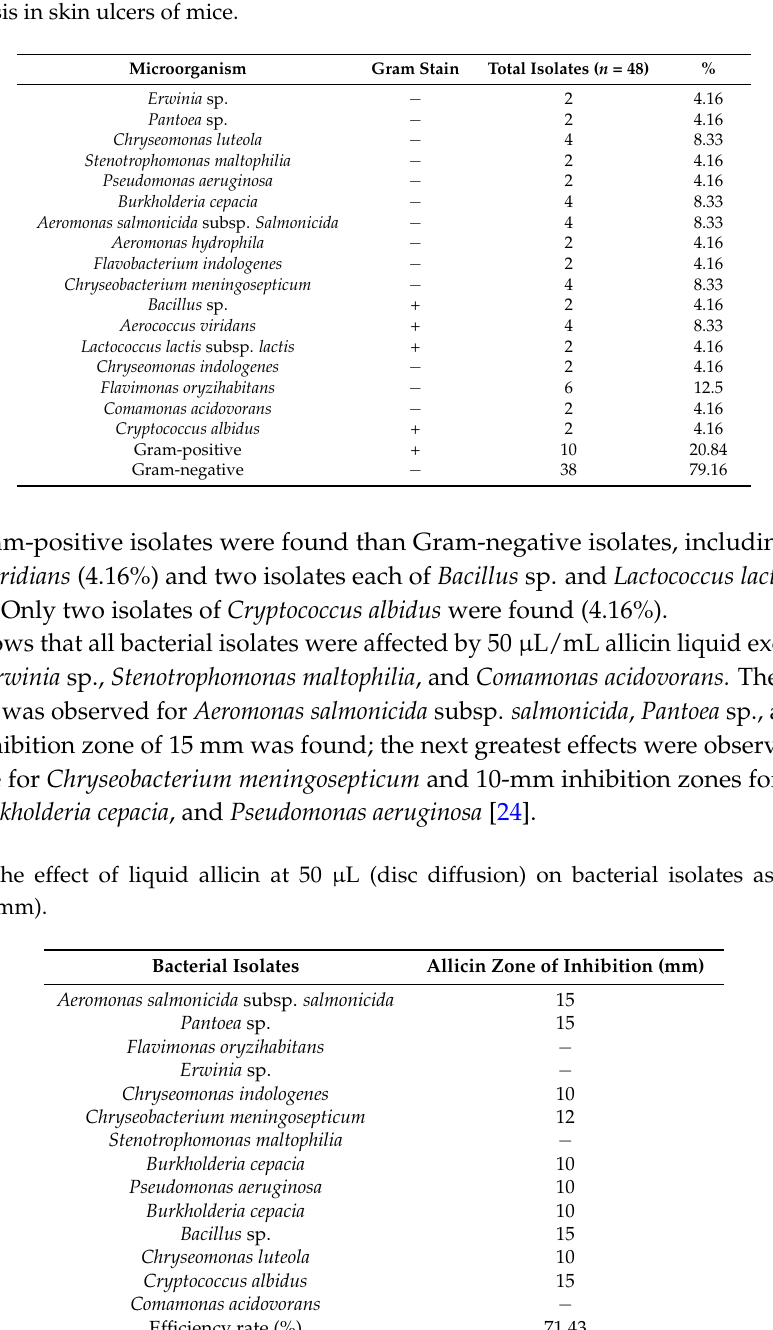
Table 2. Percentages of Gram-positive and -negative microorganisms isolated from cutaneous leishmaniasis in skin ulcers of mice.